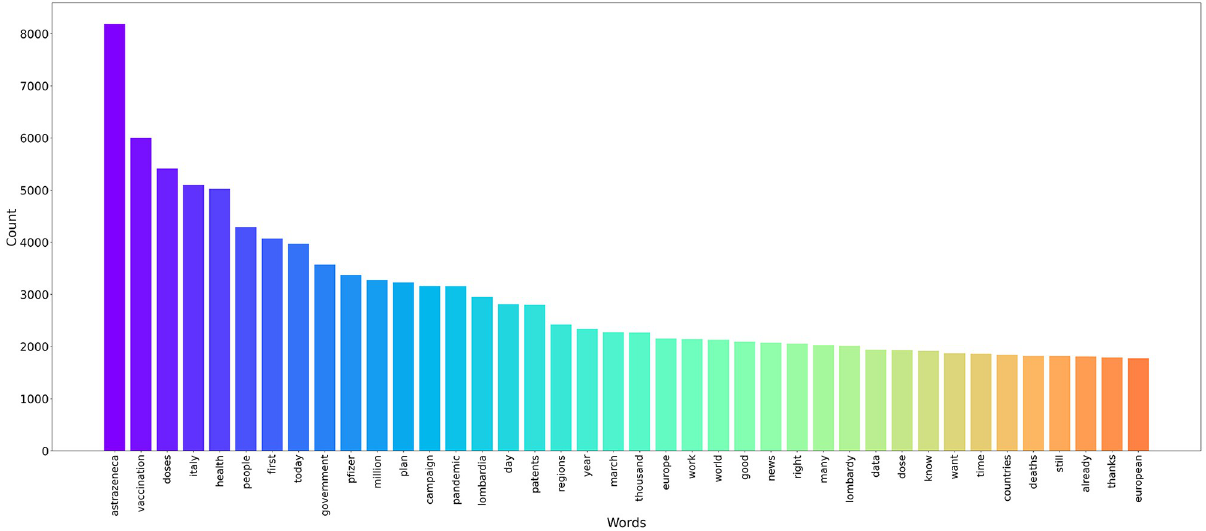
Fig 2. The total text word frequency. After removing irrelevant words, word frequency of main opinion is counted and visualized.